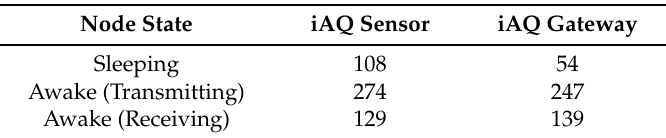
Table 1. WSN consumption (mA).